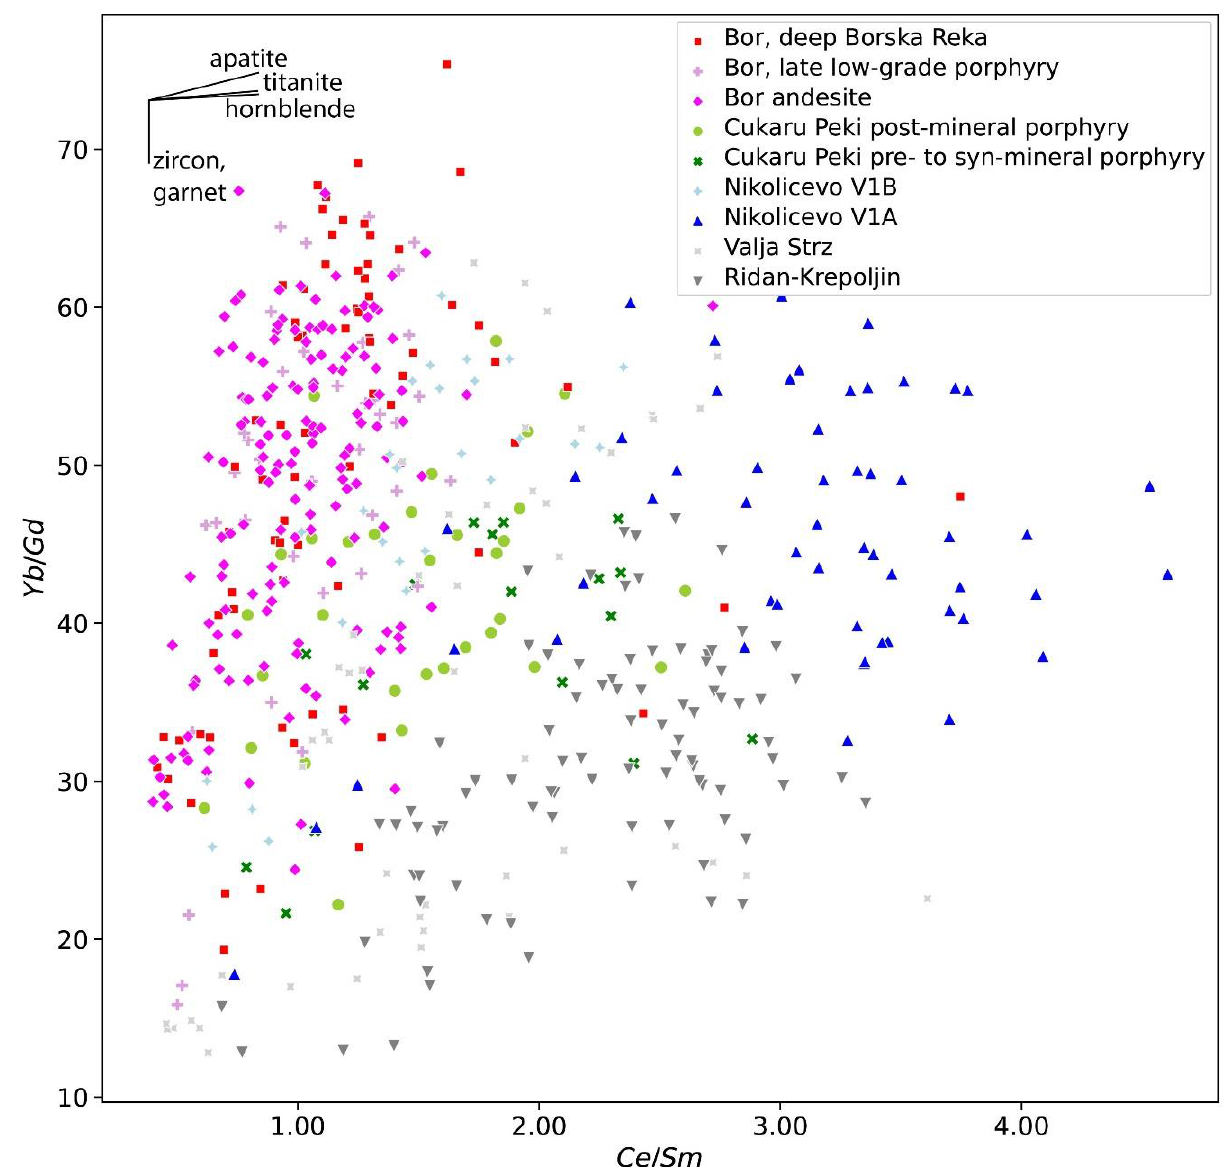
Figure 13 . Normalized Yb/Gd vs. Ce/Sm of zircons, showing separation between Bor, Cukaru Peki and Nikolicevo V1B, on one side, and Valja Strz, Ridan Krepoljin and Nikolicevo V1A. Crystal fractionation vectors from [37].